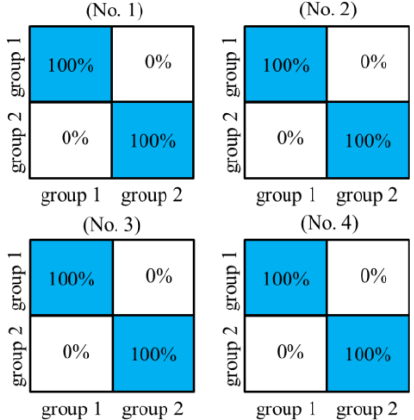
Figure 10. Fault classification of the proposed method, there are four steps in the fault diagnosis process.